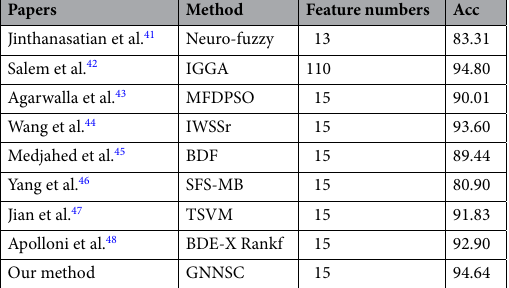
Table 2. Comparison with published advanced methods.